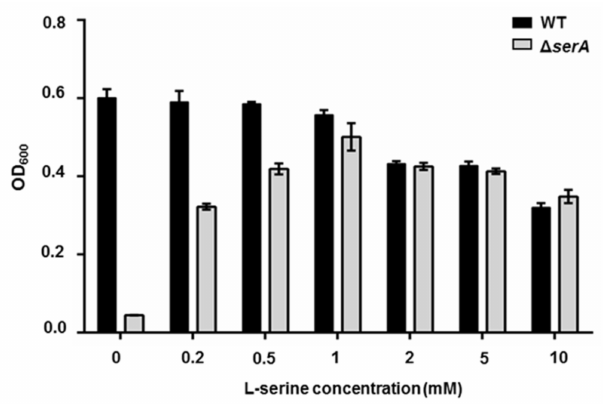
Figure 3. Comparison of the growth of P. polymyxa WLY78 and the ∆ serA mutant in medium containing different concentrations of serine. The OD 600 was measured at the stationary phase when growth reached maximum value. The medium contained NH 4 NO 3 as the nitrogen source. Results are representative of at least three independent experiments, mean values ± SDs were calculated from three sets of independent